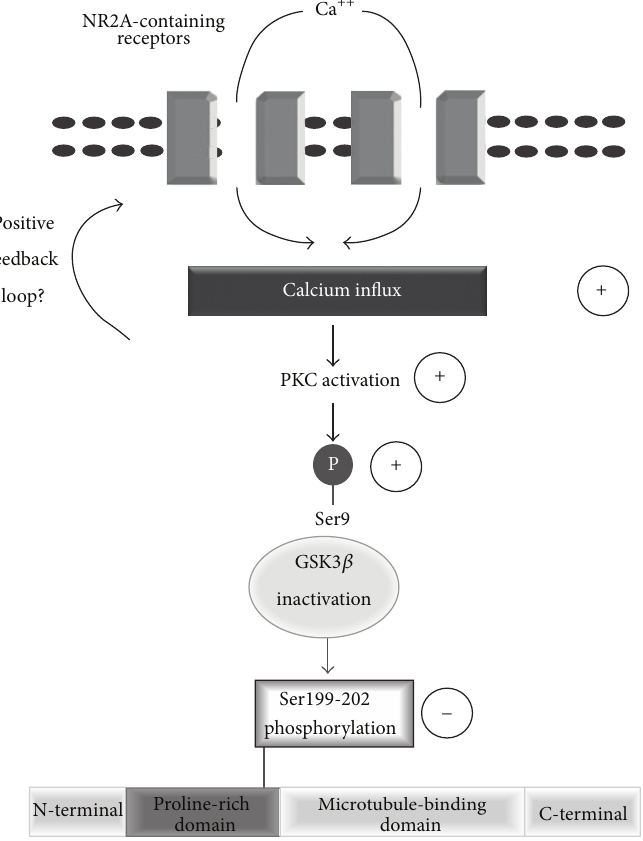
Figure 8: Working model of NMDA-induced reduction of Tau phosphorylation. Activation of NR2A-containing receptors appears to initiate Tau phosphorylation through a mechanism involving calcium accumulation and, consequently, GSK3 𝛽 inactivation via Ser9 phosphorylation by PKC. Through an unknown mechanism, the PKC/GSK3 𝛽 pathway could selectively reduce the phosphorylation of Ser199-202 residues in the proline-rich domain of Tau. Physiologically, activation of NR2A-containing receptors may reduce Tau phosphorylation which could have an impact on protein localisation and aggregation in neurons. The possibility of a positive feedback loop between PKC activation and stimulation of NMDA receptors cannot be excluded [27]. Accordingly, Jones et al. [28] recently demonstrated that activation of the atypical isoform PKC zeta (PKC 𝜁 ) is selectively coupled with potentiation of NR2A-containing NMDA receptors.